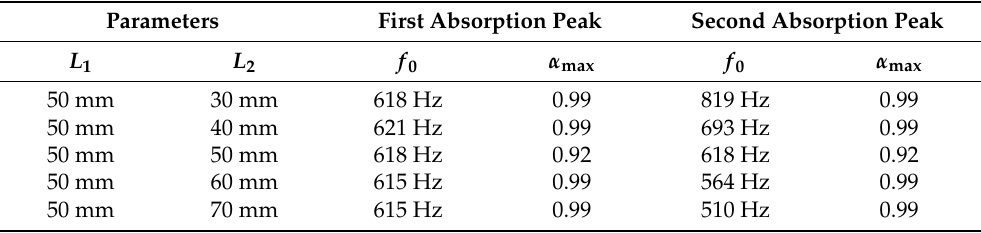
Figure 6. The influence of the length of the cavity to sound absorption performance of the double resonators in simulation. Table 3. The summary of the peak sound absorption coefficient α max and resonance frequency f 0 for double resonators with different length of the cavity.